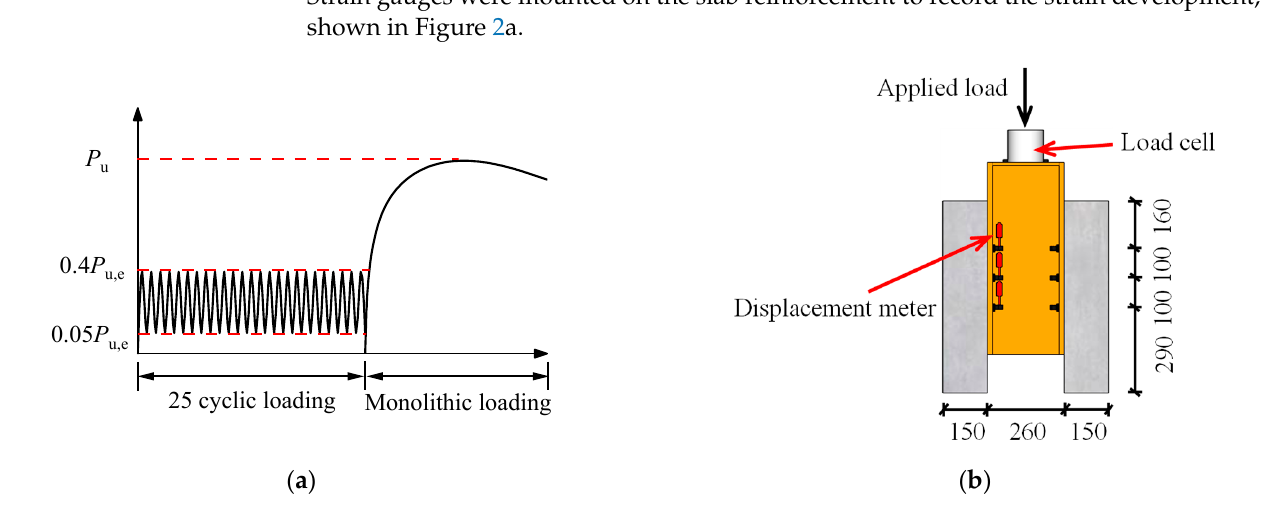
Figure 3. Loading regime and test setup: ( a ) loading regime; ( b ) test setup.